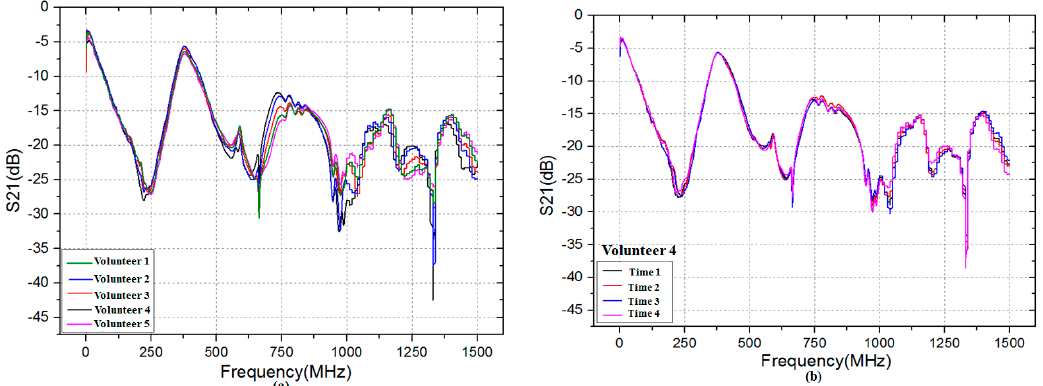
Figure 5. Transmission gain S21 in the frequency range 0.3 MHz to 1500 MHz: ( a ) five volunteers at the same time; and ( b ) Volunteer 4 at four different times.